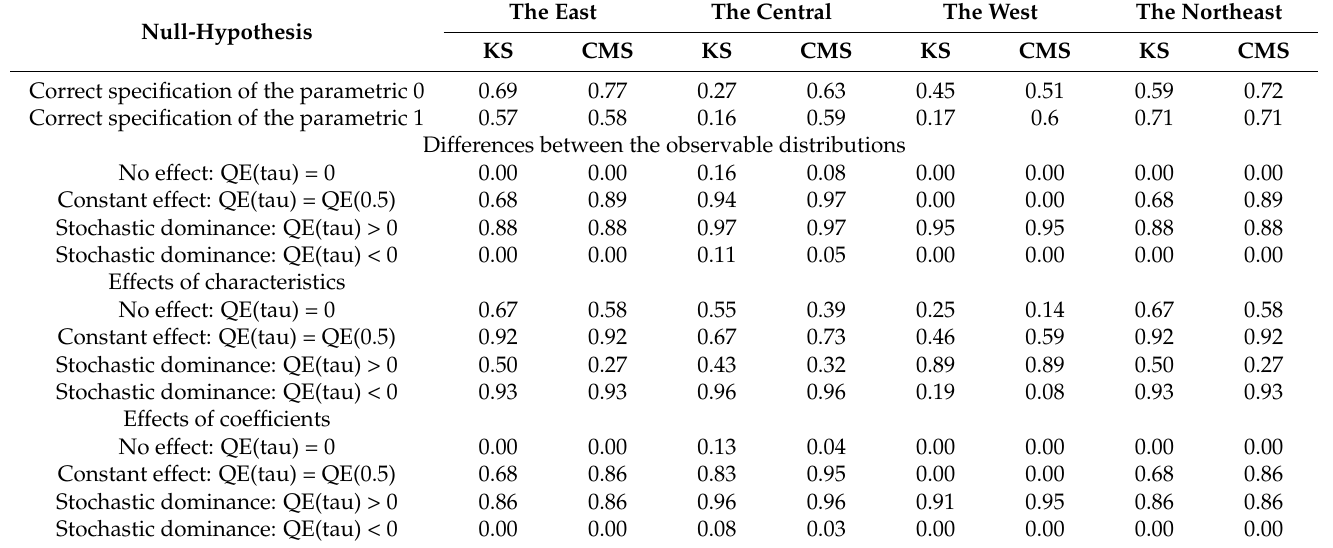
Table 6. Bootstrap test results of quantile counterfactual